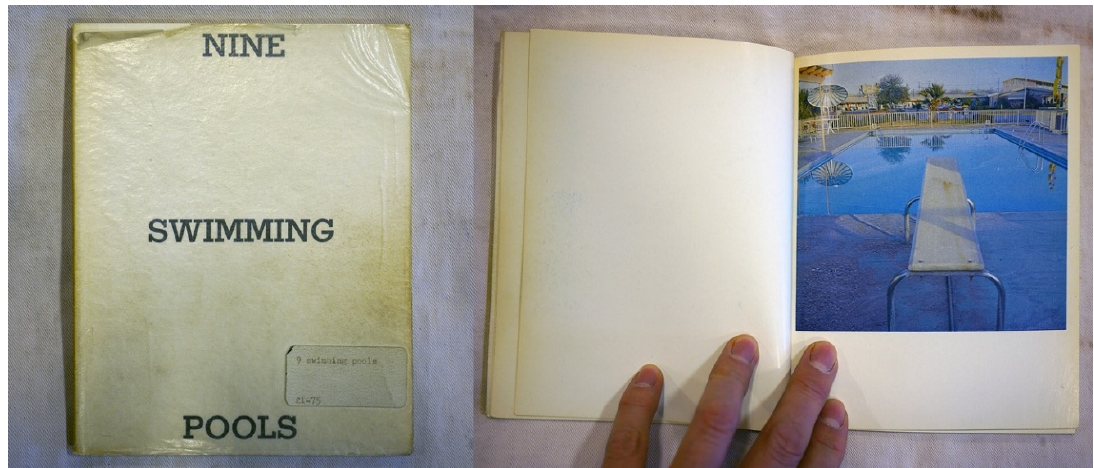
Figure 4. Edward Ruscha, Nine Swimming Pools and a Broken Glass , 1968. Courtesy of Arnolfini and Bristol Archives.